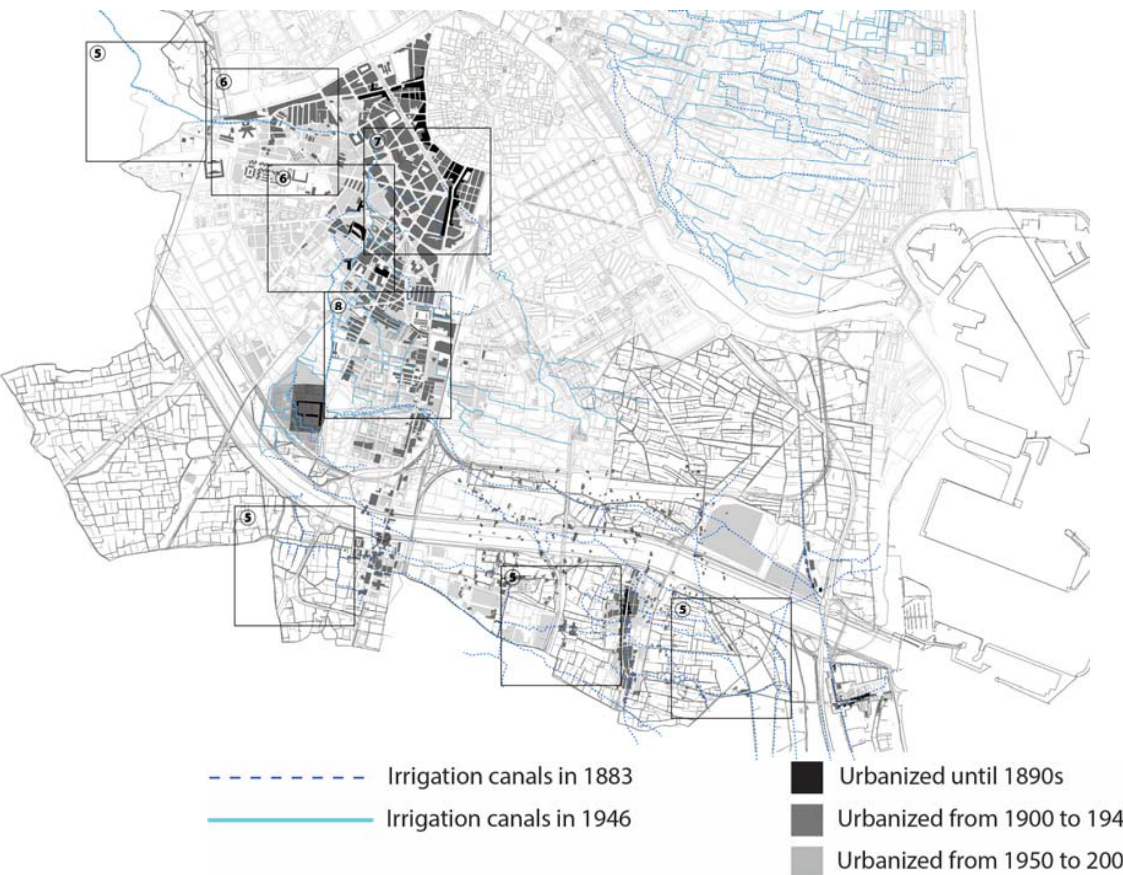
Figure 9. ( 5 (cid:13) – 8 (cid:13) ) The transformation of the irrigation canals and the urbanization phases, along the itinerary of Acequia de Favara.